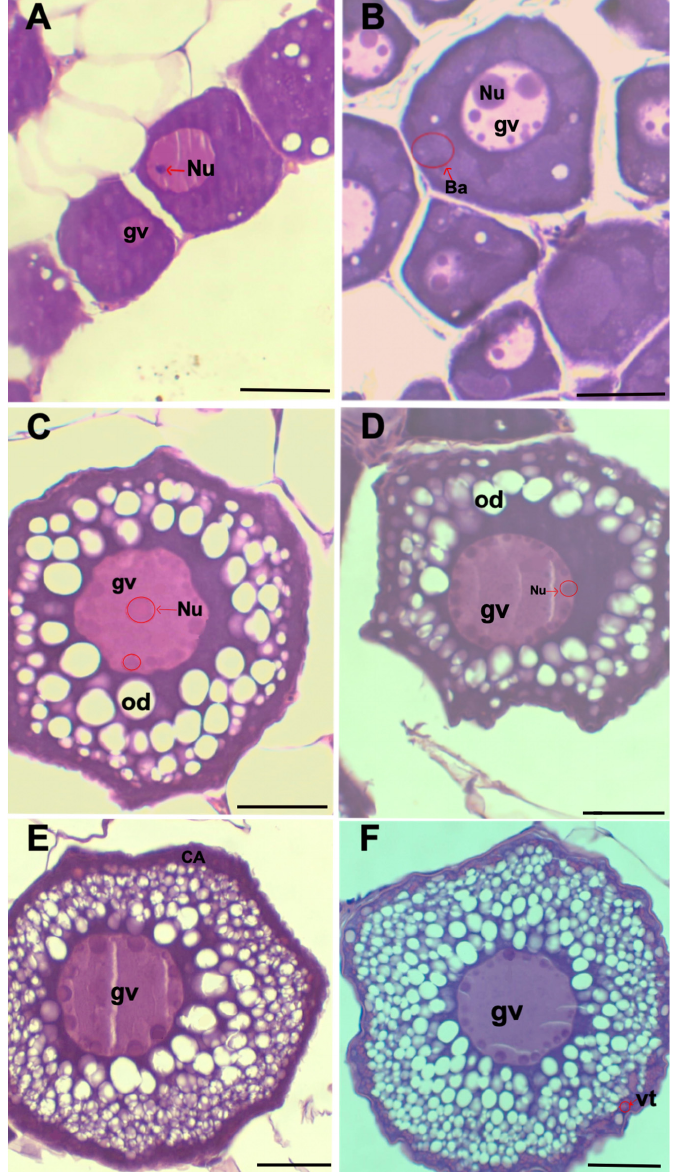
Figure 2. ( A ) One-nucleoli stage. ( B ) Multiple nucleoli stage. ( C ) Perinucleolar stage. ( D ) Circumnuclear oil droplets (stage IV of pre-vitellogenesis). ( E ) Cortical alveolar (stage V of pre- vitellogenesi). ( F ) Early secondary growth (oocyte in secondary growth with vitellogenin granules). Germinal vesicle (gv). Nucleoli (Nu). Oil droplet (od). Cortical alveoli (CA). Vitellogenin (vt). Scale bar: 20 µm.